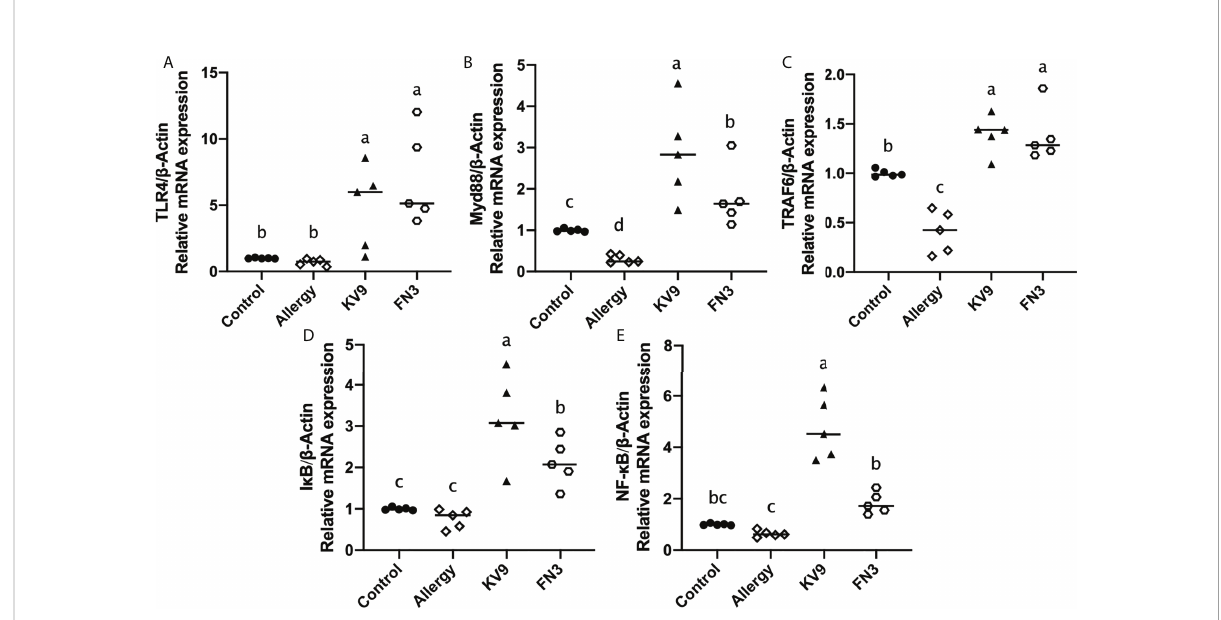
FIGURE 7 Gene expression of the TLR4-NF- k B signal pathway in DCs. The results were quanti fi ed as the density ratio between the gene of interest and the reference standard ( b -actin). Identical lowercase in the fi gure indicates the lack of signi fi cance ( p < 0.05).